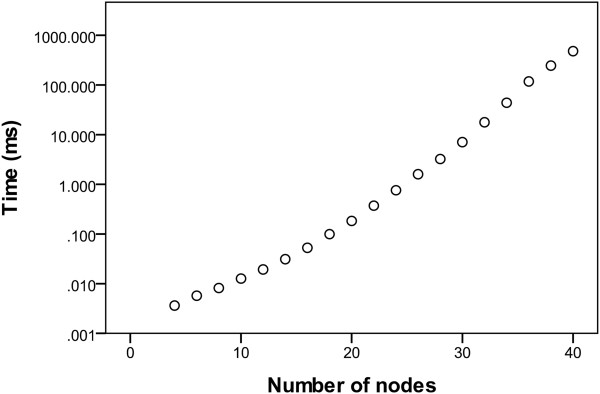
Stable state calculation time for a discrete model. x-axis: number of involved nodes. y-axis: Time (in milliseconds) needed to determine the stable states of a standardized network with the given number of nodes. The Additional file 1 explains the definition of the network for a given number of nodes.